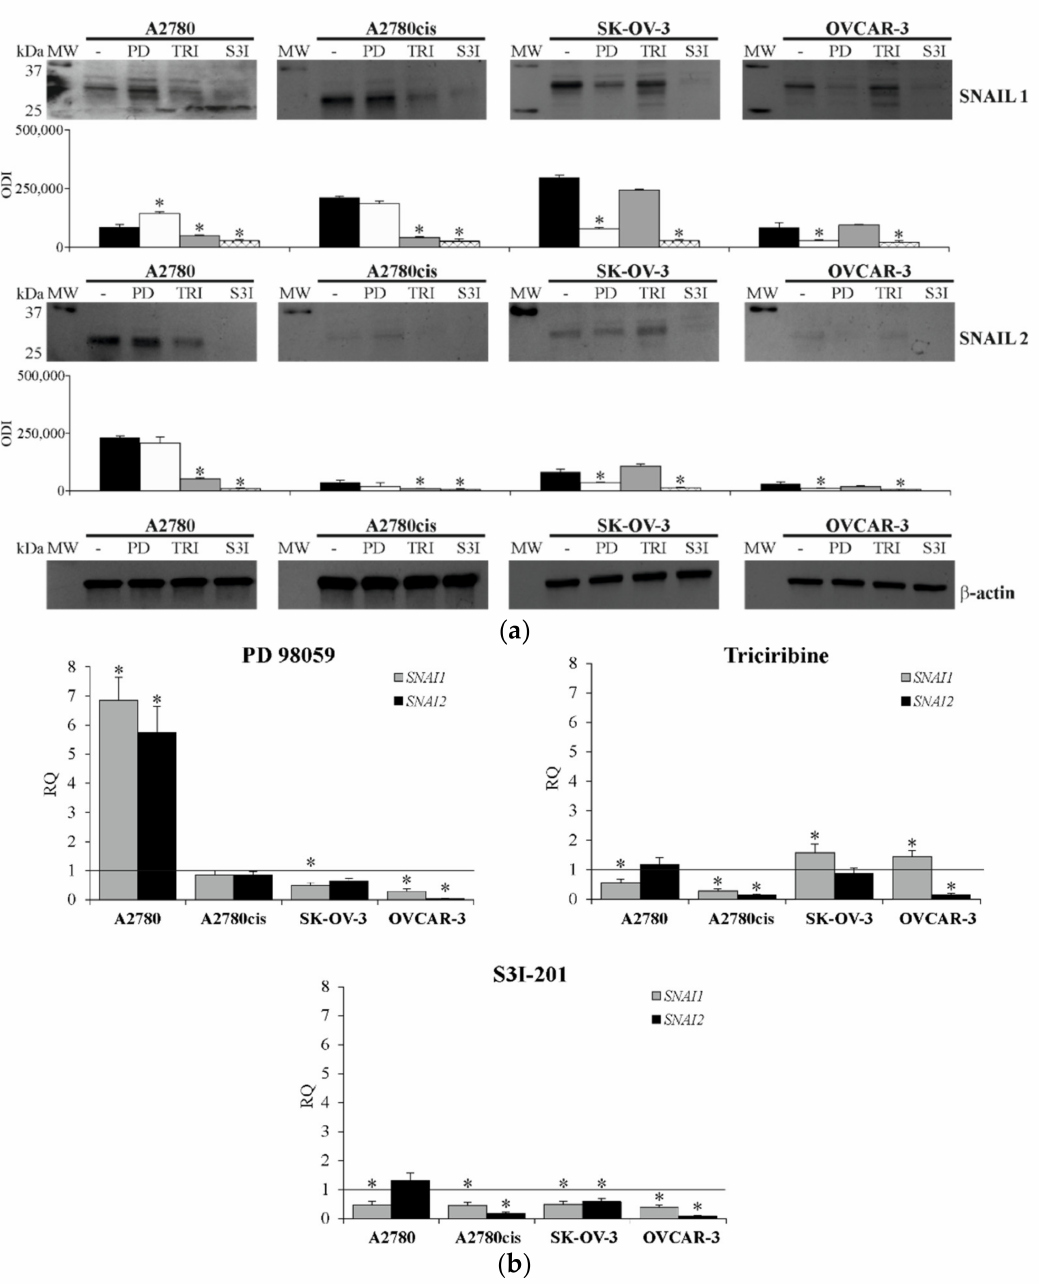
Figure 7. The expression of SNAIL 1 and SNAIL 2 in A2780, A2780cis, SK-OV-3 and OVCAR-3 cell lines treated with inhibitors. All cell lines were cultured with PD98059 (PD) (50 µ M) or Triciribine (TRI) (50 or 100 µ M) or S3I-201 (S3I) (50 or 100 µ M) or not (control) for 48 h. ( a ) The level of SNAIL 1 and SNAIL 2 was determined with immunobloting-ECL